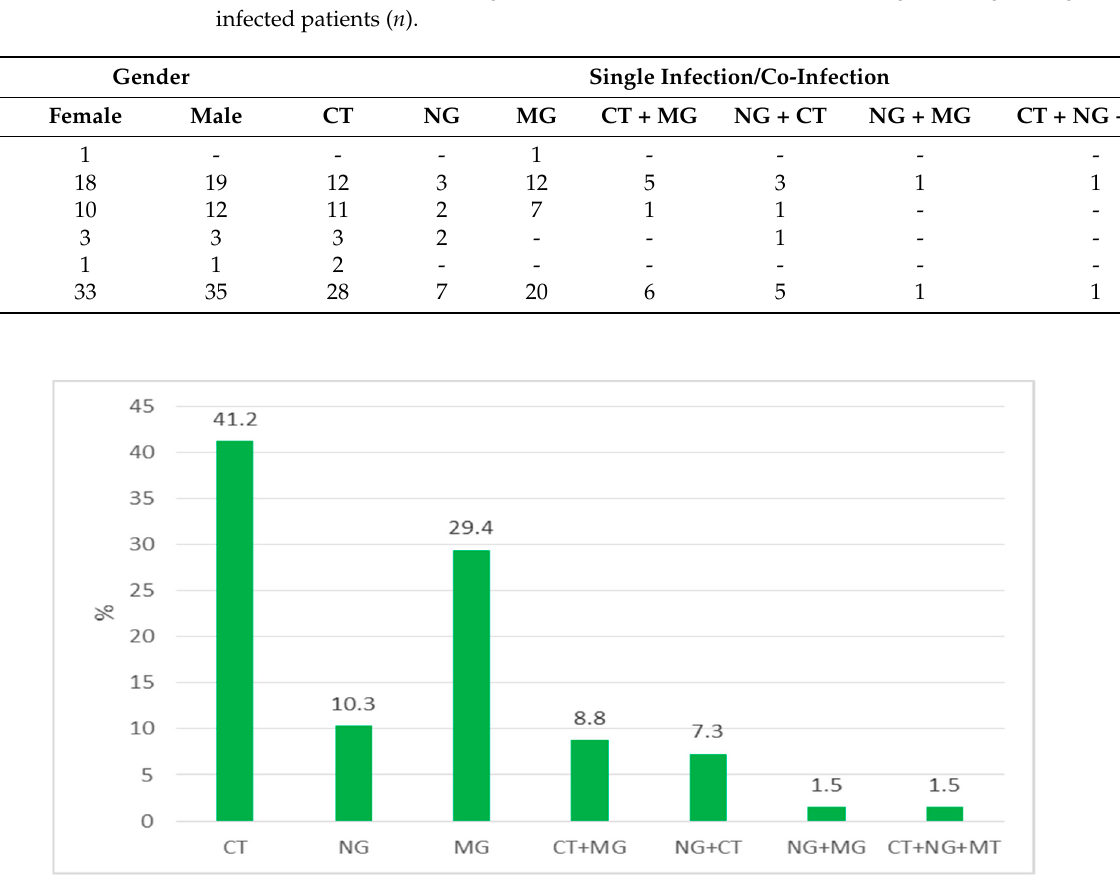
Figure 1. Distribution of the single infections and co-infections among infected patients. One of the three patients infected with CT and one of the seven infected with MG were individuals living with HIV. One of the patients with NG–CT coinfection was an individual living with HIV. In three patients, the presence of Treponema pallidum was also detected. Table 3 shows the co-infections with different STI parameters. Table 3. Distribution of co-infection status with different STI agents of these patients ( n ).